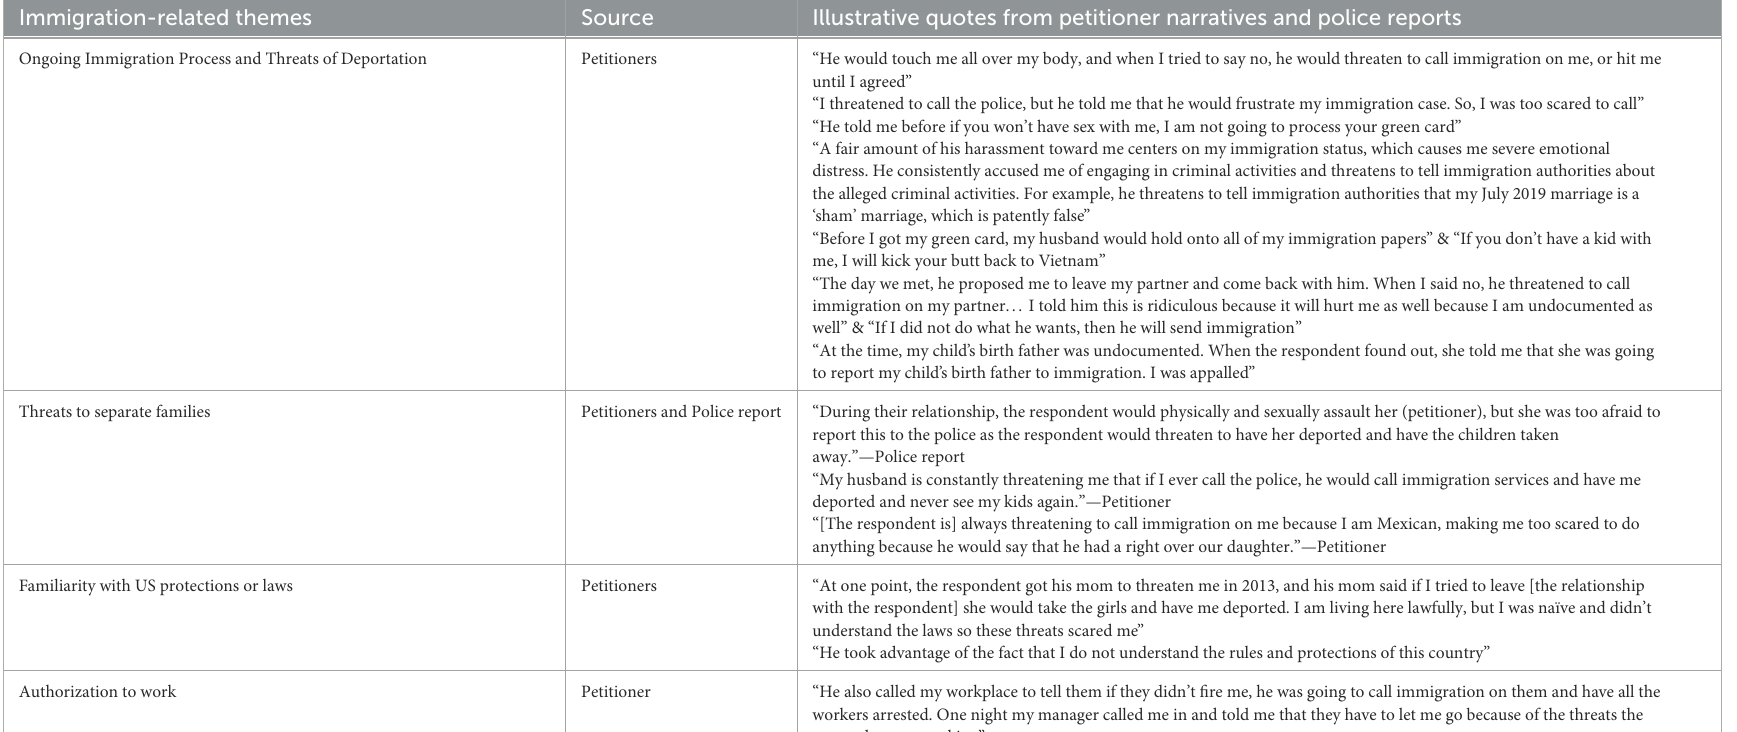
TABLE 1 Immigration-related themes and illustrative